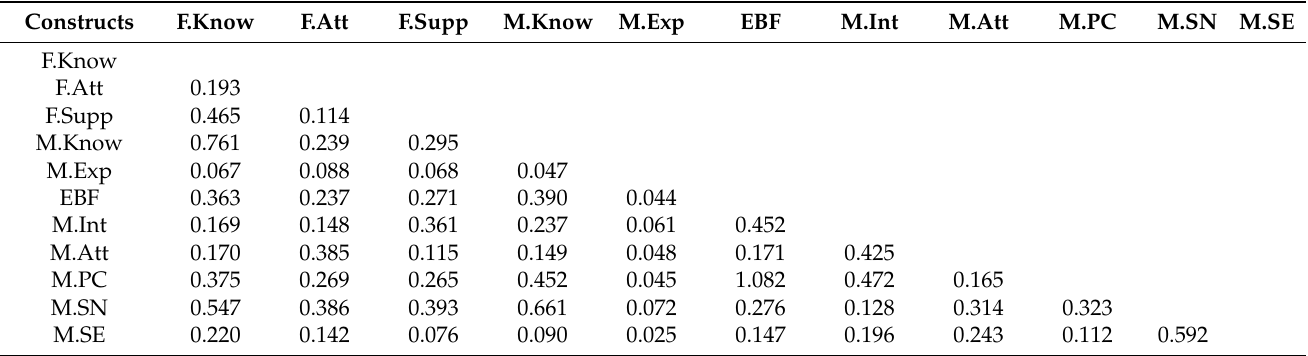
Table 5. Output of Heterotrait–Monotrait (HTMT)